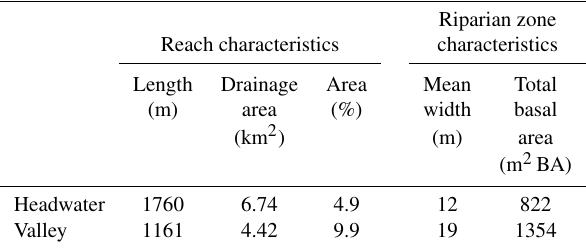
Table 1. Reach length, catchment drainage area, percentage of ri- parian area, width of the riparian zone, and total basal area of ripar- ian trees for the headwater and valley